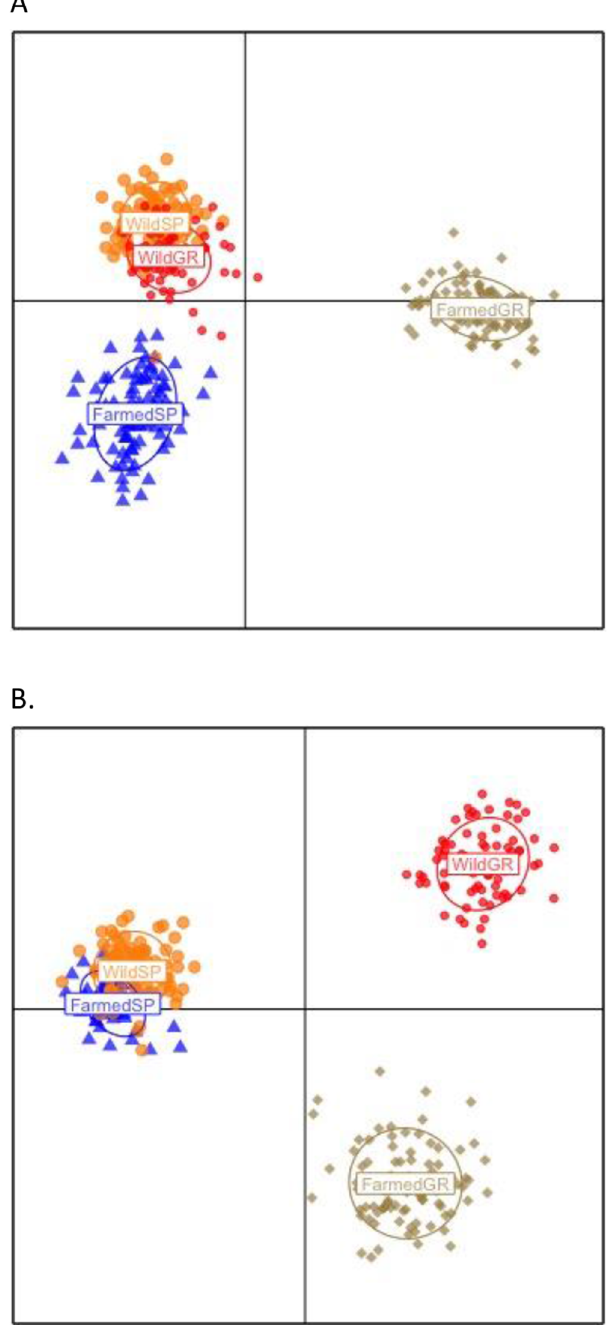
Fig. 2. Discriminate analysis of principal components (DAPC) A. S. aurata B. D labrax . Different colors represent different